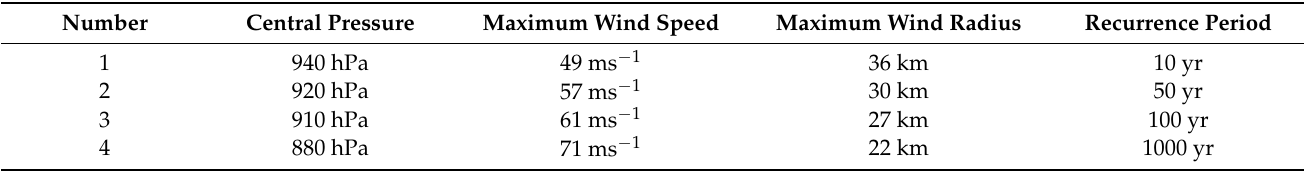
Table 6. Information of each